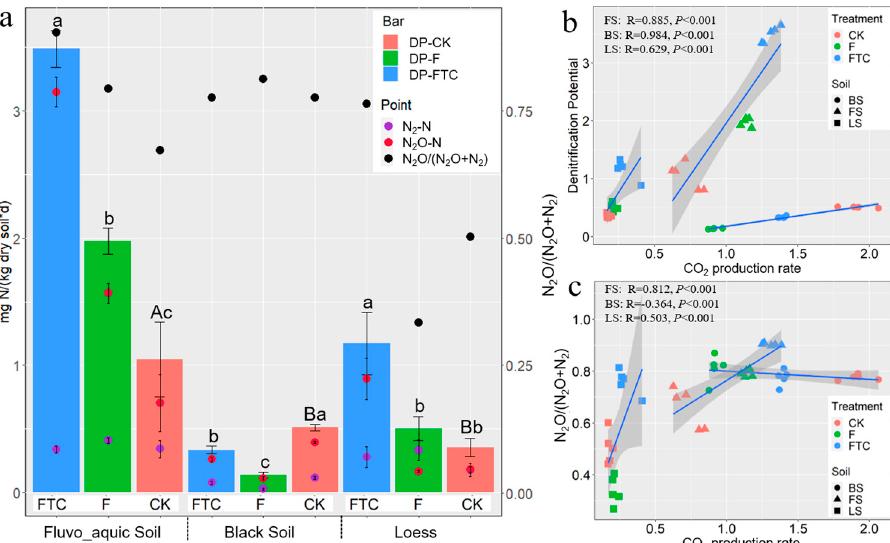
Figure 3. ( a ) Soil denitrification potential (DP) (bar diagram), N 2 -N production rates (purple point diagram), N 2 O-N production rates (red point diagram) and the N 2 O/(N 2 O + N 2 ) ratio (black point diagram); ( b ) Relationship between soil CO 2 production rates and denitrification potential in three treatments from three types of soils; ( c ) Relationship between soil CO 2 production rates and the N 2 O/(N 2 O + N 2 ) ratio in three treatments from three types of soils. Different lowercase letters in the bar chart indicate significant differences in denitrification potential between the FTC, F and CK treatments in the same soil type determined by Duncan’s test; different uppercase letters in the bar